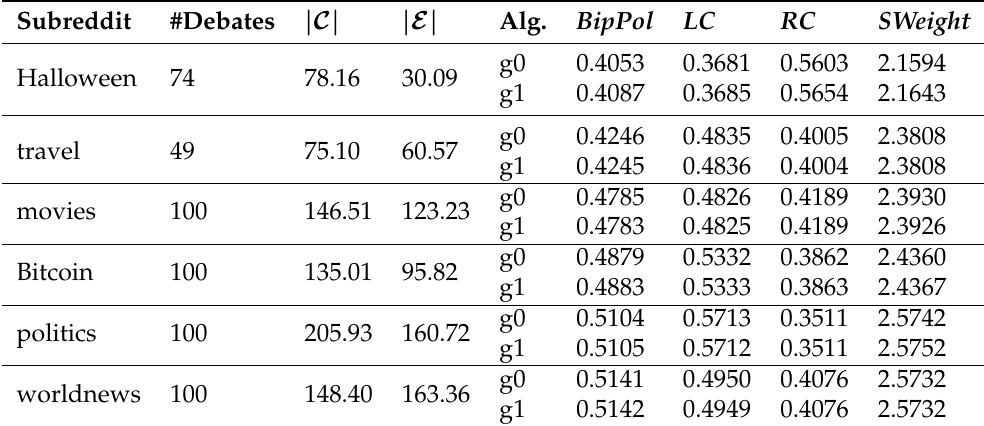
Table 1. Results with different initialization algorithms with debates from several subreddits. The numbers shown are average values over the debates of each